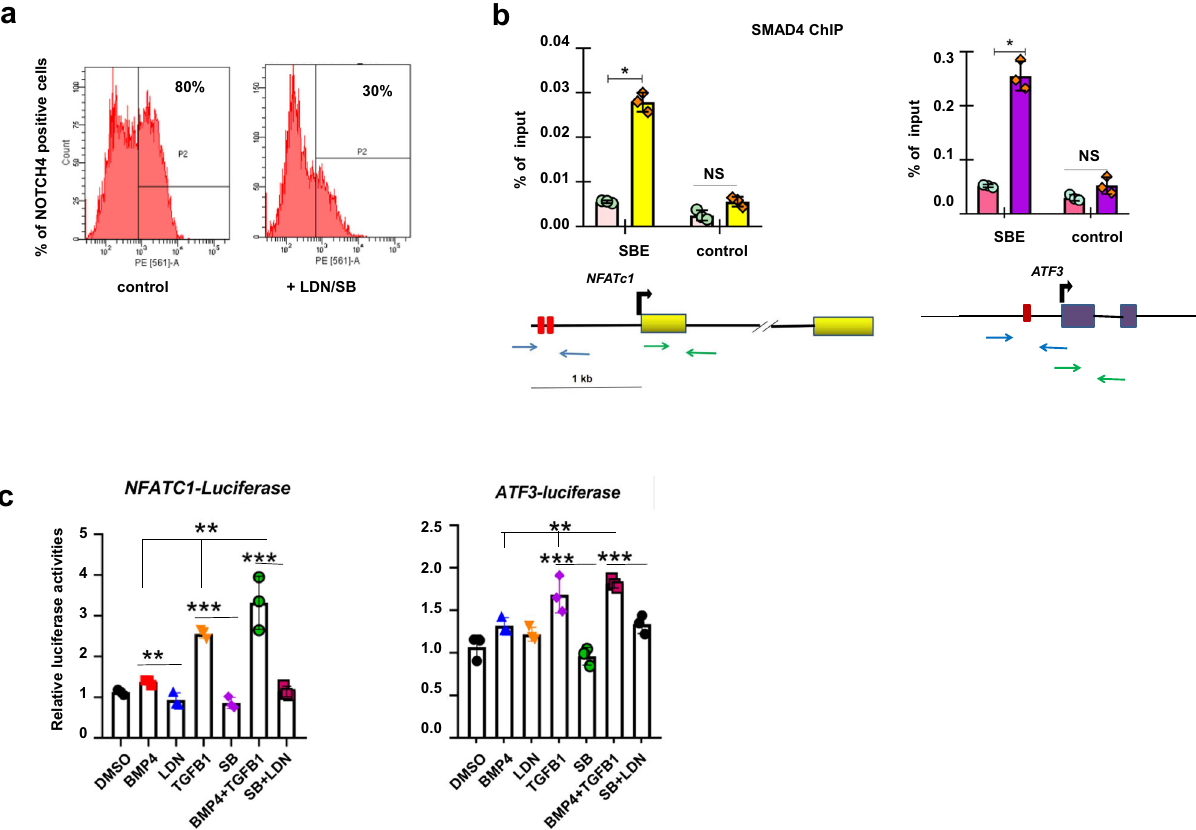
Fig. 5 BMP4 and TGFb1 induce VEC fate by promoting NFATc1 / ATF3 . a Flow cytometry analysis of day 7 hPSC-derived VELs in the presence and absence of SB and LDN, showing the percentage of NOTCH4 positive cells. b ChIP experiments showing the enrichment of SMAD4 at NFATc1 and ATF3 promoters. c Luciferase reporter assay showing NFATc1 and ATF3 promoter activities in the presence and absence of LDN and SB. Experiments were repeated at least two times. The paired t test in Graphpad software was used for the statistical analysis. Signi fi cant levels are: * p < 0.05; ** P < 0.01; *** P <